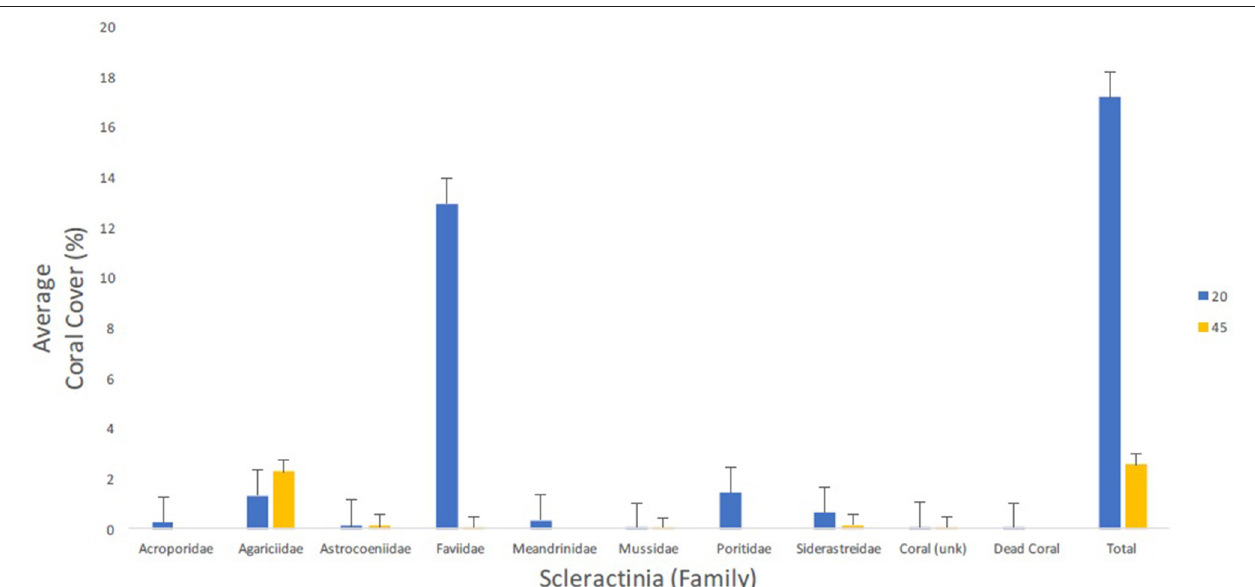
FIGURE 6 | Average percent cover ( + SE) per coral family from both the altiphotic and deep transect surveys along the central portion of the Guánica shelf edge. A total of 40 m 2 were surveyed per depth stratification and percent cover was calculated in CPCe and tabulated using custom Linux scripts.